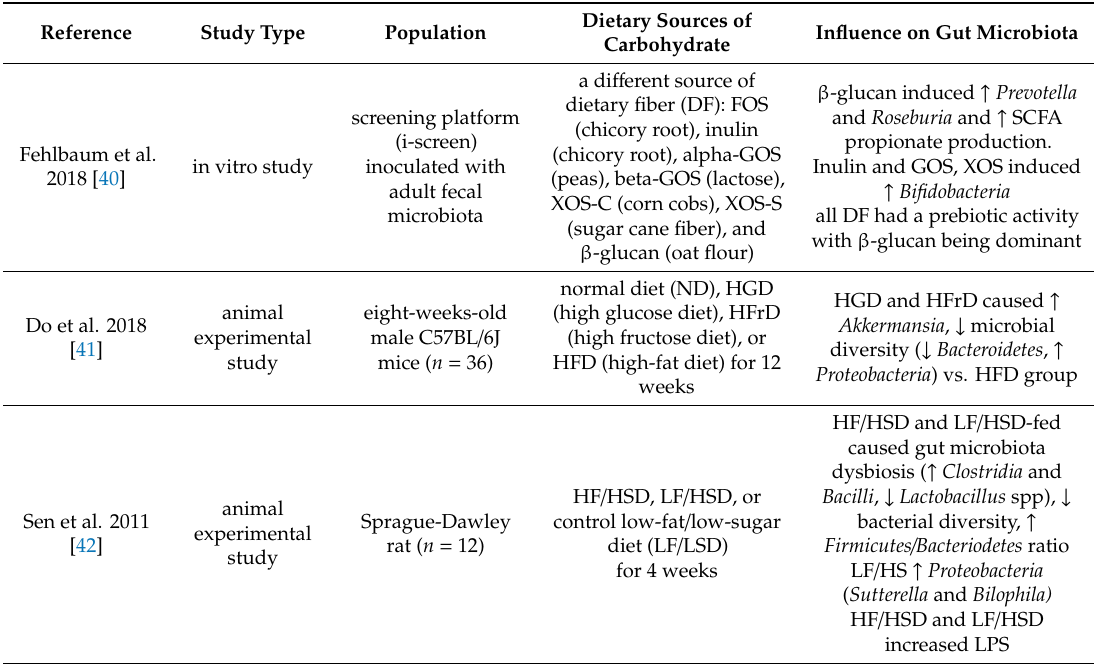
Table 1. Influence of digestible and non-digestible carbohydrates on gut microbiota